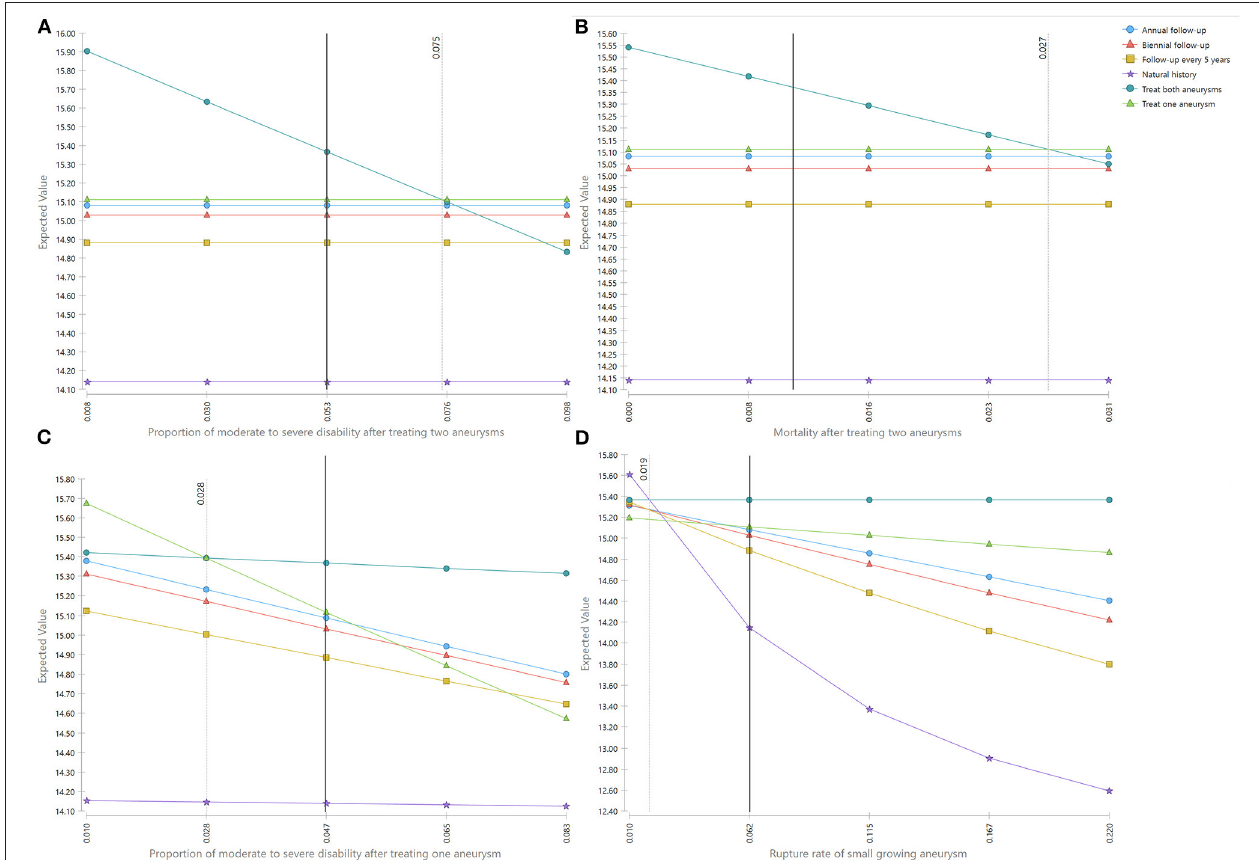
FIGURE 2 | (A–D) One-way sensitivity analyses. The light-dark line represents the threshold. The deep-dark line represents the base case value.